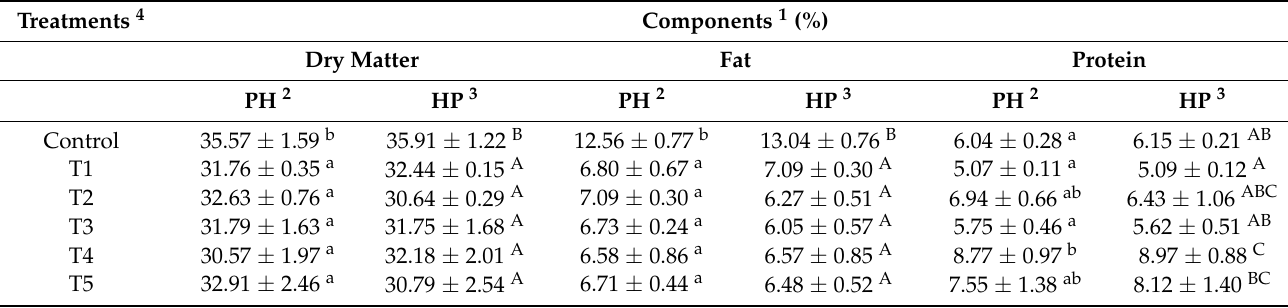
Table 2. Chemical composition of all treatments with and without microparticulated whey proteins, including the control